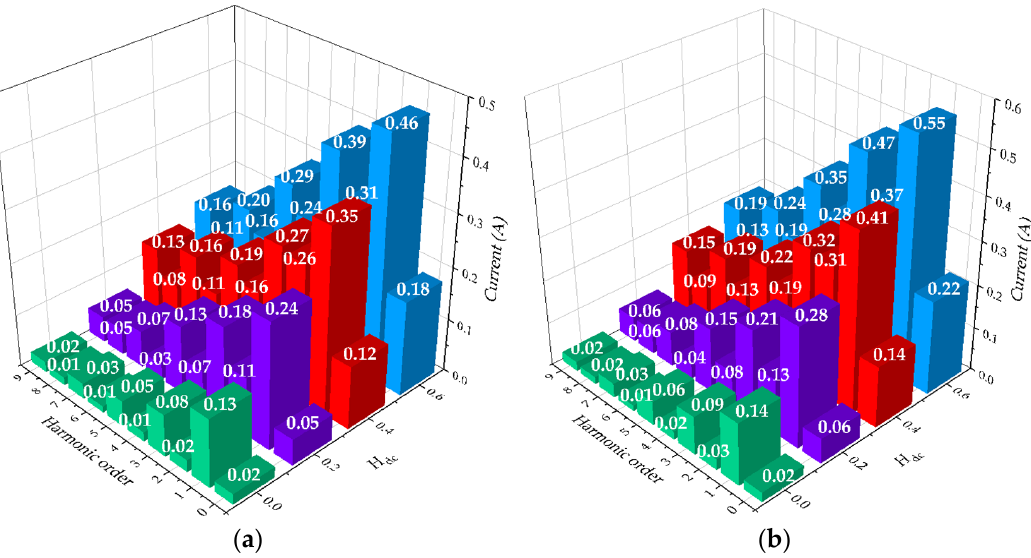
Table 3. Electromagnetic parameters with di ff erent DC bias. Figure 10. Excitation current spectrum analysis. ( a ) Interleaved windings; ( b ) Continuous windings.